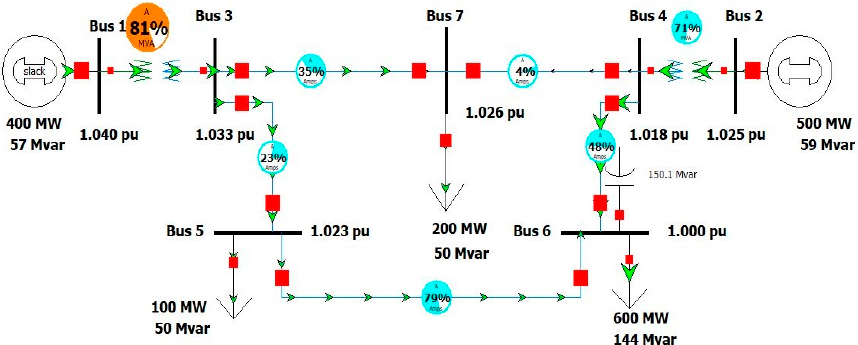
Figure 20. Power flow of the 7 bus system after adding a shunt capacitor to bus 6.